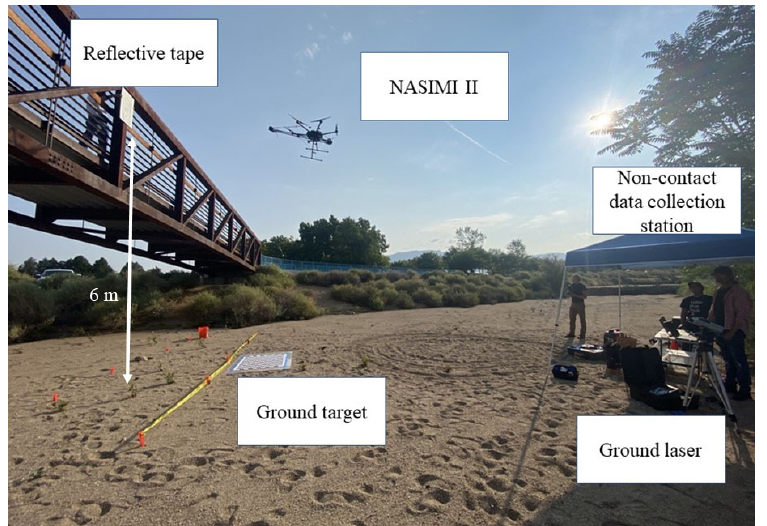
Figure 7. Field deployment of NASIMI II. The DJI Matrice 600 has an airframe diameter of approxi- mately 1.6 m. With the addition of the laser boom the diameter was increased to 2.2